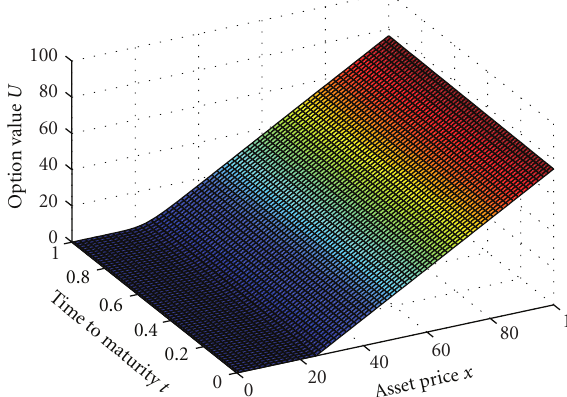
Figure 1: Computed option value U for Test